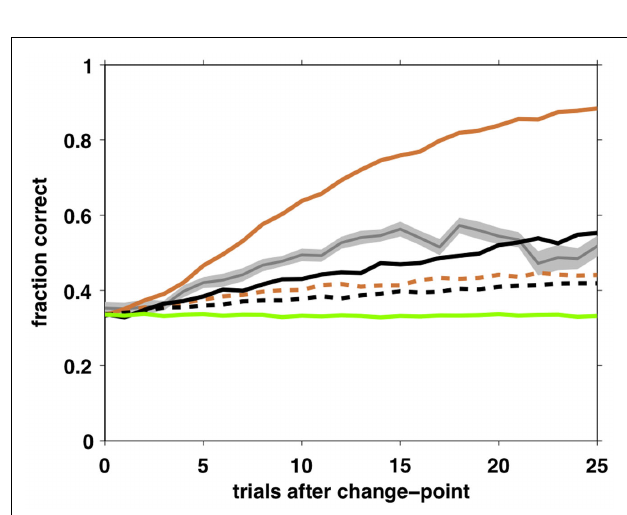
FIGURE 10 |Average learning curves for simulated agents performing 10,000 trials of the task with unsignaled changes. Black – full selective attention model with optimal (solid) and fit (dashed) parameters; Orange – Bayesian model with constant hazard rate with optimal (solid) and fit (dashed) parameters; Green – SA rand with fit parameter values; Gray – human data (shading: